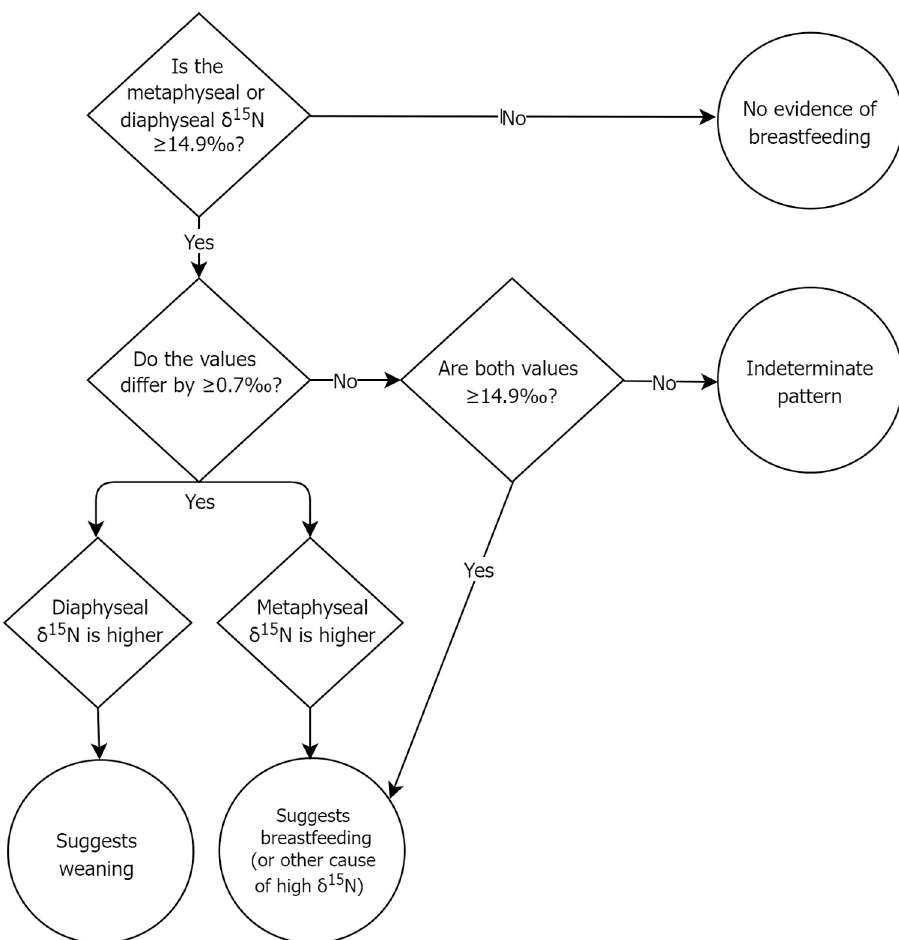
Fig 2. Interpretive method 1 decision tree for categorizing infant feeding status at death from paired metaphyseal and diaphyseal δ 15 N values.